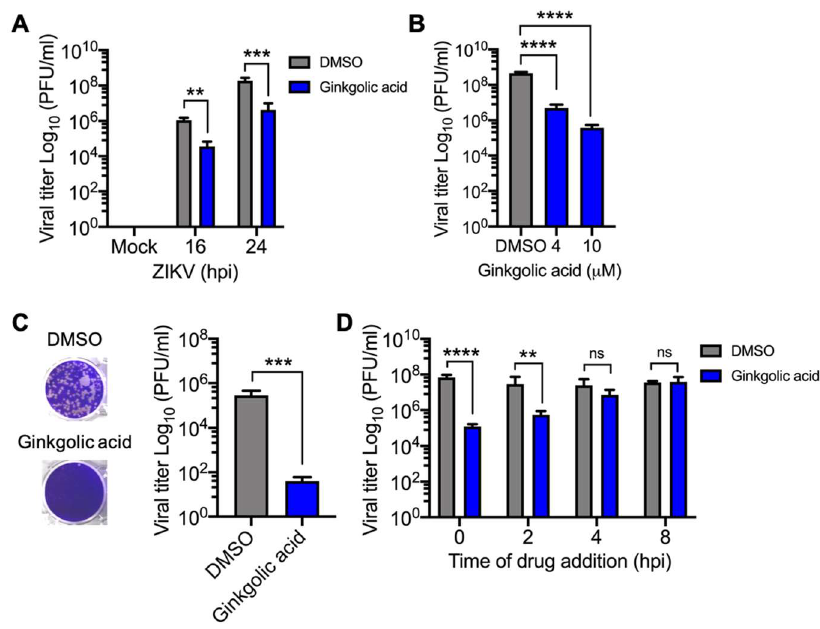
Figure 6. Ginkgolic acid also inhibits Zika virus (ZIKV) replication. ( A ) Vero cells were pre-treated with 10 µ M Ginkgolic acid or 0.1% DMSO. After 1 h of incubation, the treatment medium was removed and the cells were infected with ZIKV at a multiplicity of infection (MOI) of 10. Then, fresh medium with Ginkgolic acid or DMSO was added to the cells and they were incubated for 16 or 24 hpi. Viral progeny production in the cell supernatants was measured as previously mentioned. ( B ) Vero cells were pre-treated with increasing concentrations of Ginkgolic acid and then infected with ZIKV as above. Viral titers in cell supernatants were quantified as previously described. ( C ) Nearly 10 5 PFU of ZIKV were incubated in serum-free medium with Ginkgolic acid or DMSO as described previously. The remaining virus in both experimental conditions was titrated using plaque-forming assay. ( D ) Vero cells were infected with ZIKV; after 1 h of virus absorption, Ginkgolic acid was added to the cells at the indicated times. Viral production was evaluated as previously described. Viral titers were expressed as plaque-forming units per milliliter (PFU / mL). Data were analyzed with the One- or Two-way ANOVA test and Mann & Whitney test. Statistically significant di ff erences are shown: ** p < 0.01; *** p < 0.001; **** p < 0.0001; ns: non-significant.